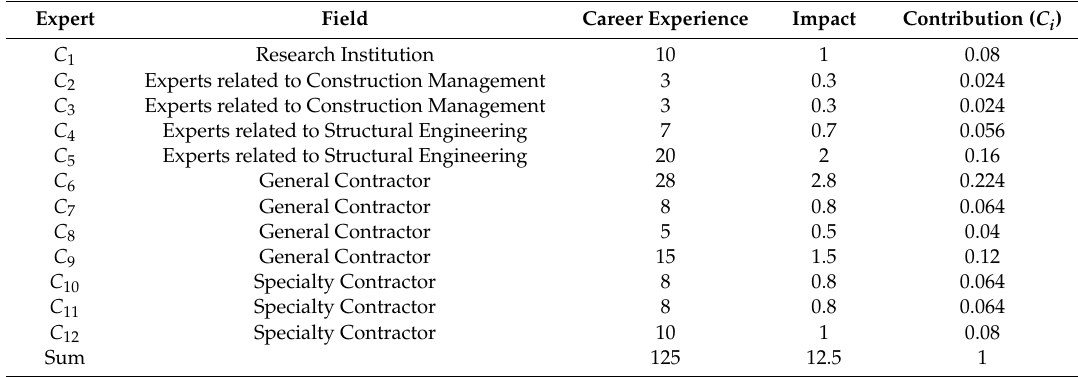
Table 7. Details of experts’